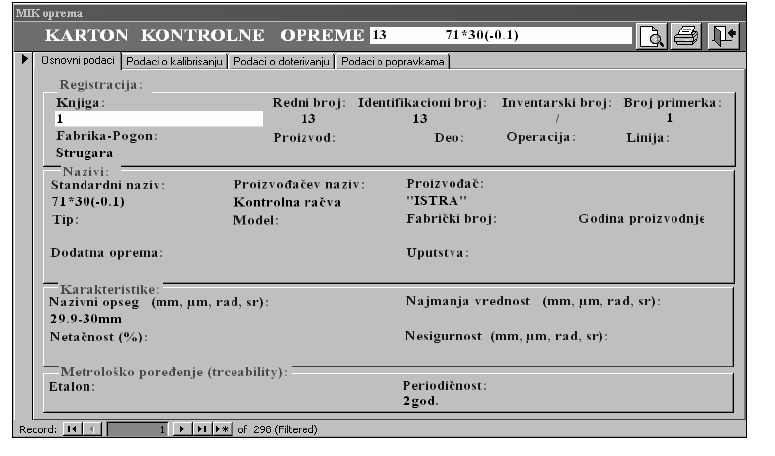
Figure 10 – Example of the window „Control equipment card“ Рис . 10 – Пример окна " Журнал контрольного оборудования